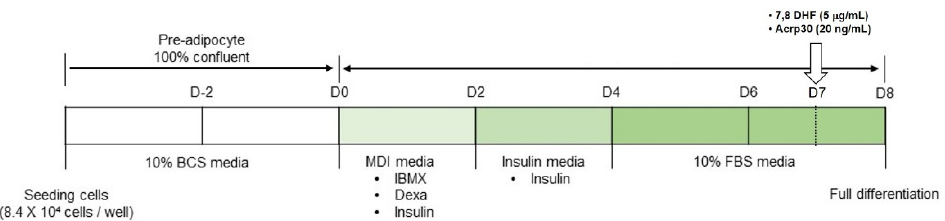
Figure 1. Differentiation protocol of 3T3-L1 cells. BCS: bovine calf serum, Dexa: dexamethasone, DMEM: Dulbecco’s Modified Eagle’s Medium, FBS: fetal bovine serum, IBMX: 1-methyl-3-isobu- tyl-xantin.